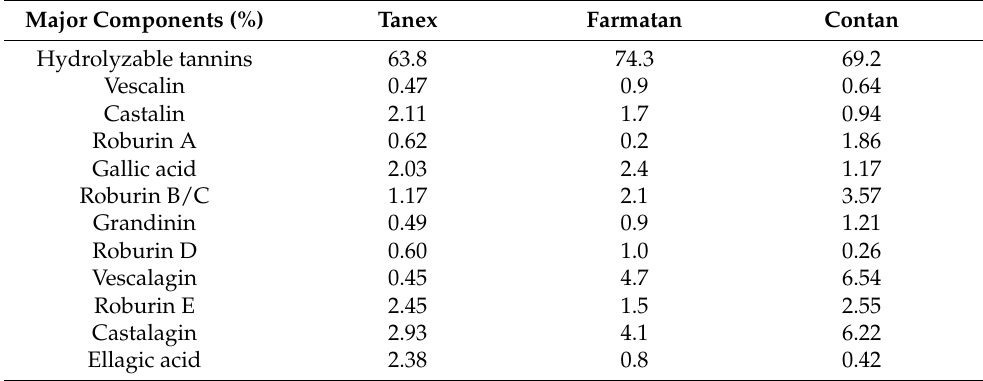
Table 1. Chemical composition of wood extracts rich with hydrolyzable